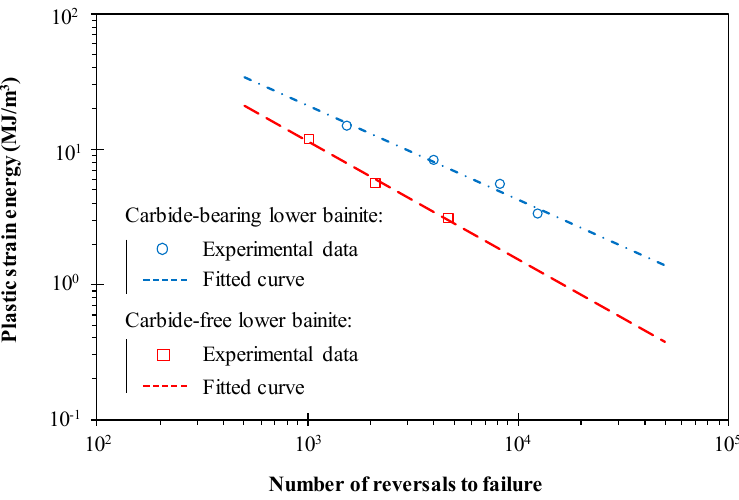
Figure 8. Plastic strain energy density versus fatigue life for the carbide-bearing and carbide-free bainitic steels.